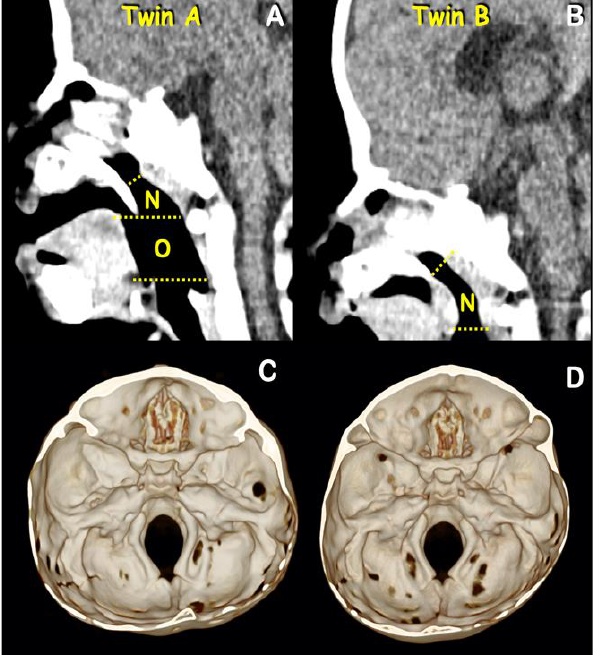
Figure 5. Sagittal view CT. ( A ) Normal naso-and oropharyngeal airways of twin A. ( B ) Normal naso-and oropharyngeal airways of twin B. Three-dimensional CT reconstruction . ( C ) Short anterior cranial bases of twin A and ( D ) twin B.